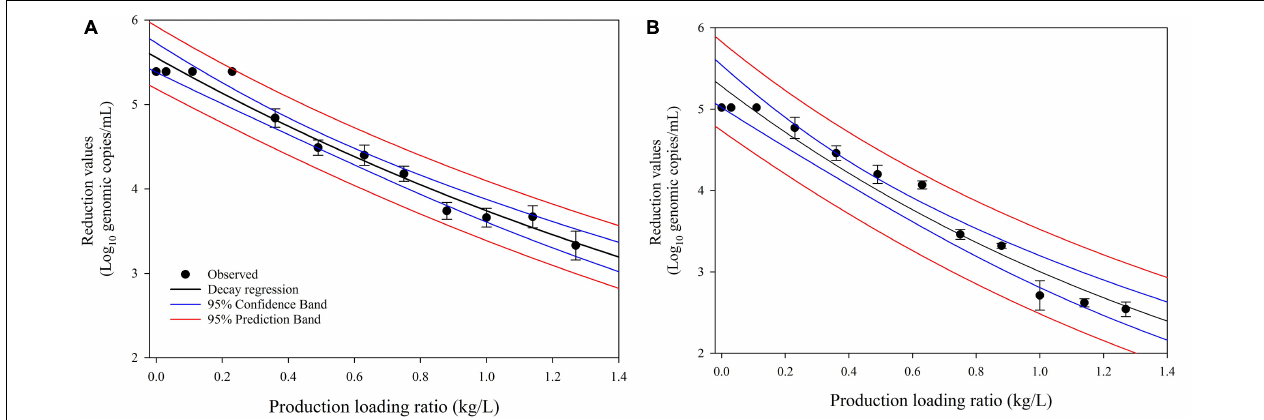
FIGURE 3 | Dynamic changes of the virucidal efficacies of (A) HuNoV GI.6 and (B) HuNoV GII.4 based on the cabbage loading ratio related to the total amount of SAEW.